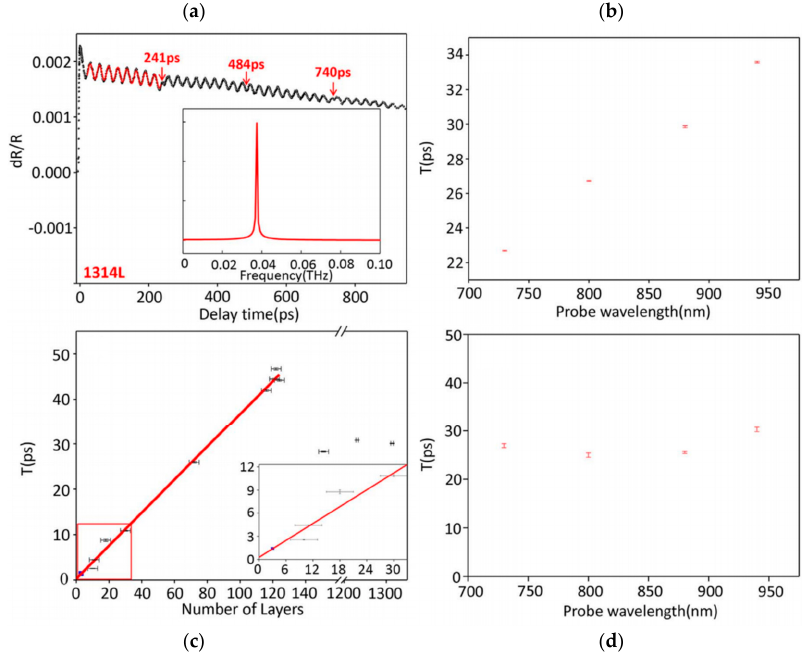
Figure 7. ( a ) Time-domain optical signal measured on a thick sample (around 800nm) of MoS 2 with oscillations attributed to propagative CAPs with phase shifts at single trip delays. ( b ) Wavelength dependence of the extracted oscillation period in the same thick sample, which follows Equation (4). ( c ) Oscillation periods extracted for samples with different thicknesses. Two regimes are observed corresponding to propagative CAP for thick samples and resonant coherent phonon (RCP) for thin ones. ( d ) Wavelength dependence of the extracted oscillation period for a 44-nm-thick sample, in the resonant regime which follows Equation (9). Adapted from [143], published by Springer Nature under Creative Commons.